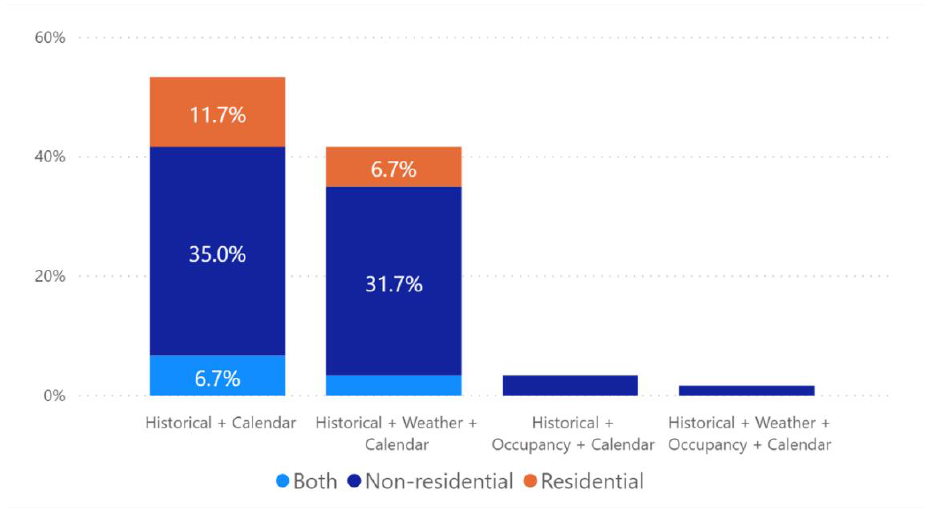
Figure 8. Comparison between building type and input variables.